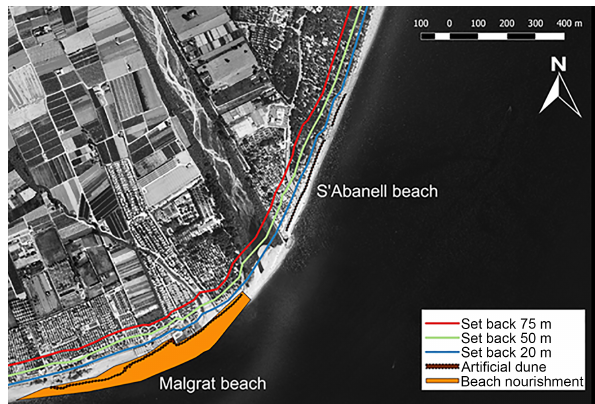
Figure 5. Risk reduction measures at Tordera Delta: receptor set- backs (20, 50, and 75m) and nourishment + dune (beach nourish- ment at Malgrat beach + artificial dune at S’Abanell and Malgrat